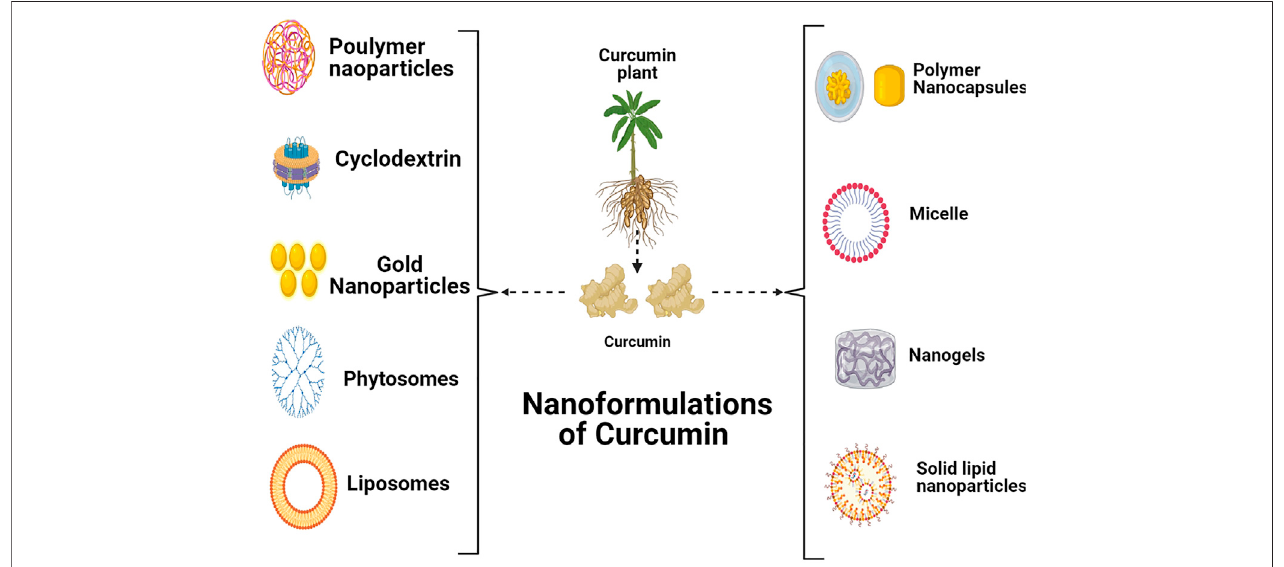
FIGURE 4 | Different types of curcumin nano-formulations for the treatment of colorectal cancer.